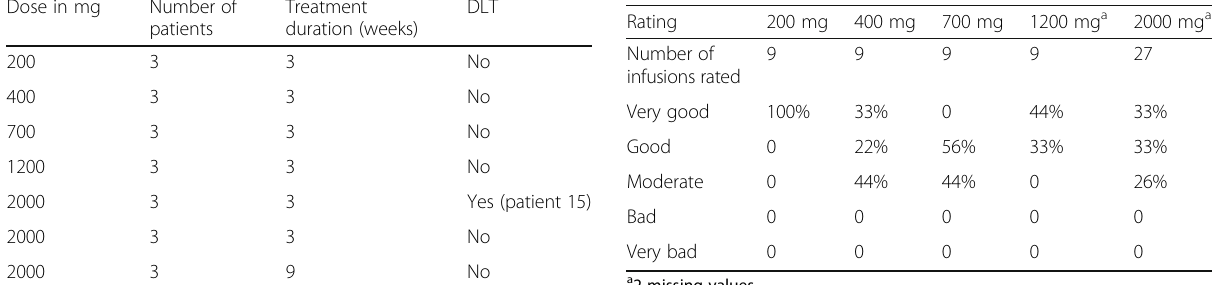
Table 3 Patients ’ rated tolerability of